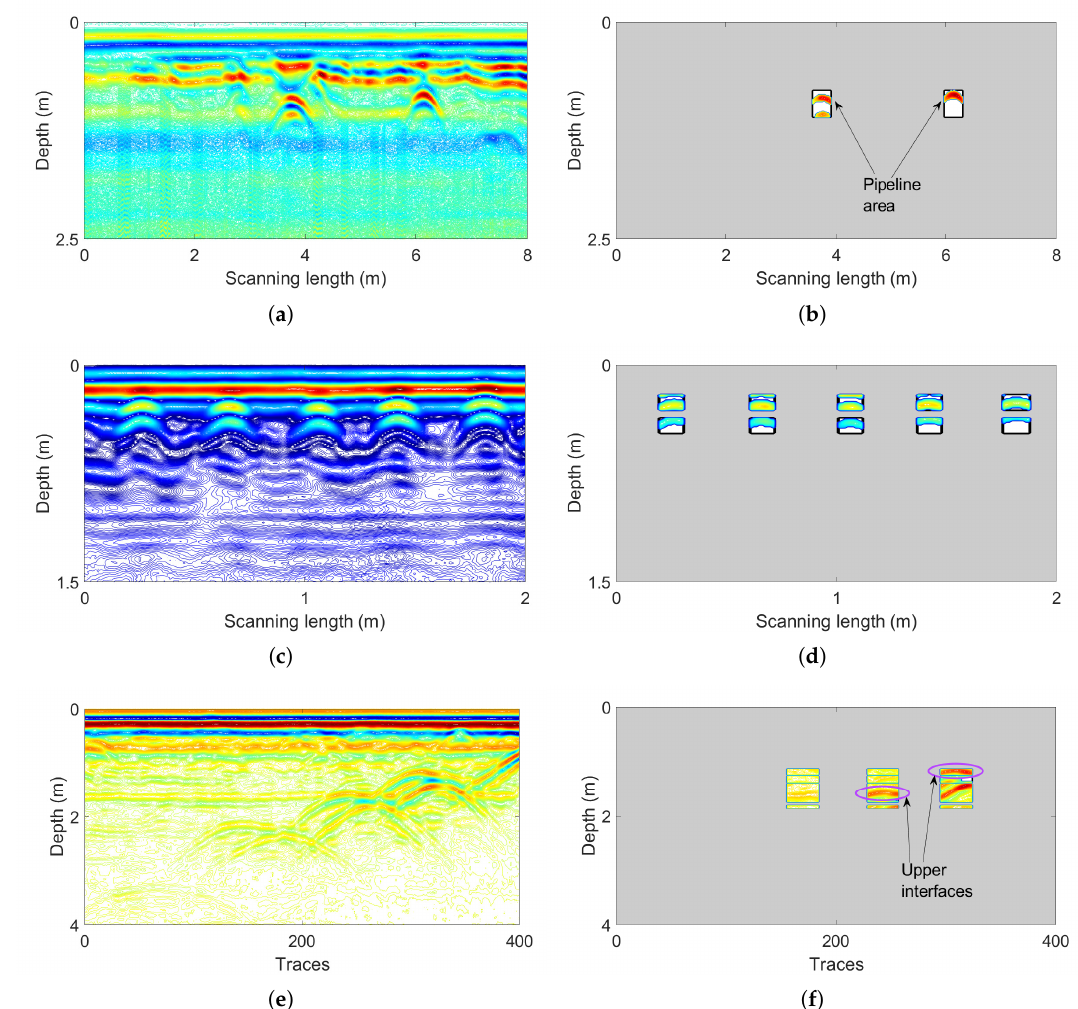
Figure 15. ( a ) Example input profile with two pipelines (diameter 32 cm). ( b ) Reconstructed profile of panel (a) by machine learning. ( c ) Example input profile with 5 × 2 cylinders (diameter 10 cm). ( d ) Reconstructed profile of panel (c) by machine learning. ( e ) Example input profile with three pipelines (diameter 50 cm, depth of upper interface 1 m, 1.5 m and 2 m). ( f ) Reconstructed profile of panel (e) by machine